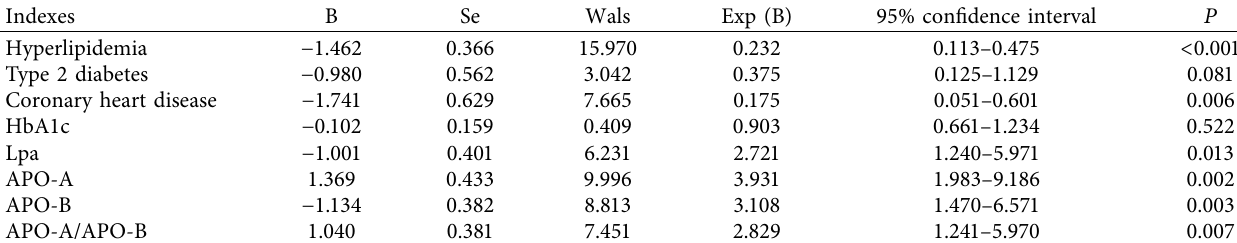
Table 3: Independent infuencing factors of MCA